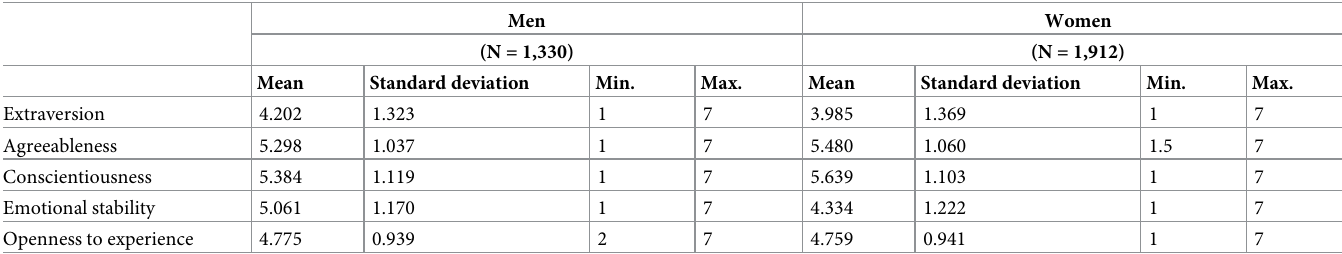
Table 3. Descriptive statistics of the Big Five personality traits by